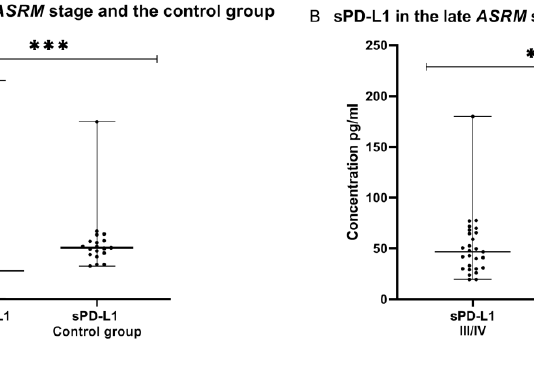
Figure 9. Levels of sPD-L1 ( A ) pg/mL and sPD-L2 ( B ) pg/mL in the plasma of patients with endo- metriosis and control group. The median values with the following sign indicate statistically sig- nificant differences: *** p < 0.001.